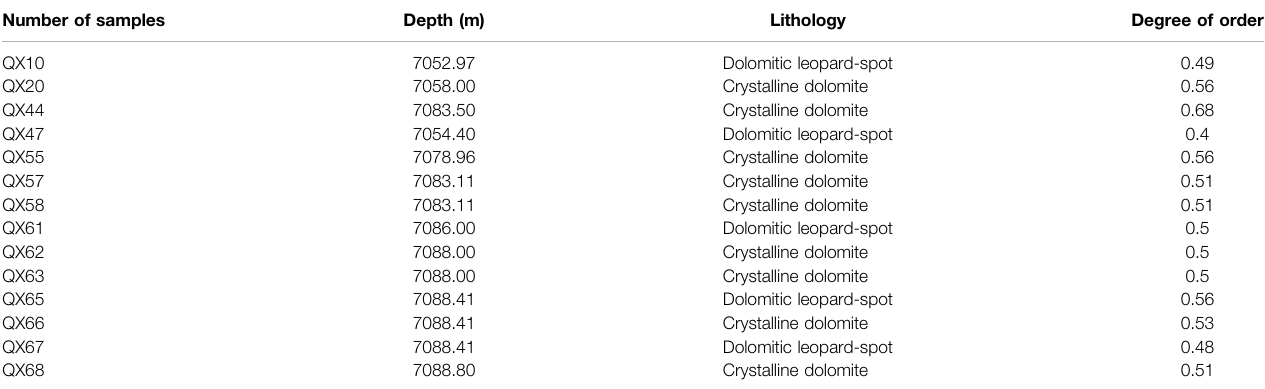
TABLE 3 | Order degree test data of dolomites of Qixia Formation in the study area. Number of samples